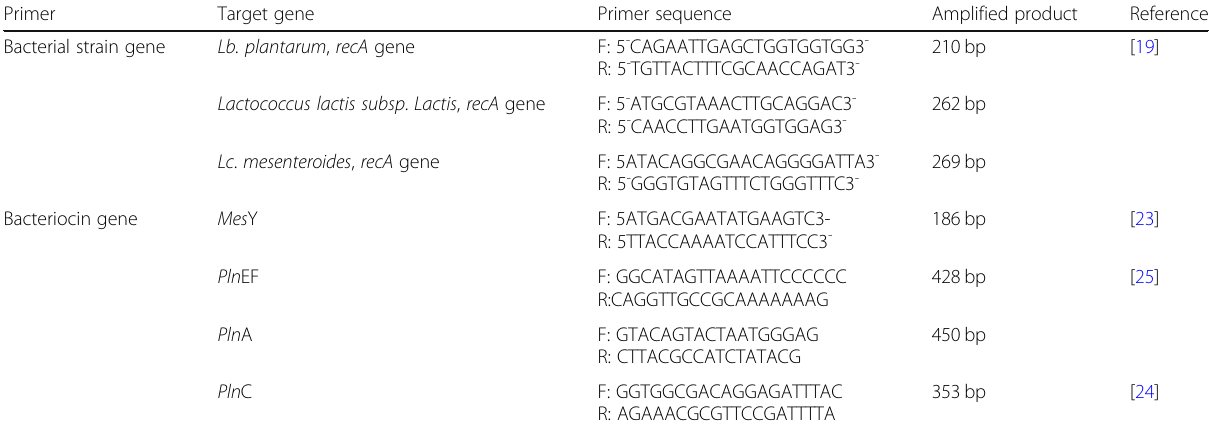
Table 1 Specific oligonucleotide primers sequences used throughout this study Primer